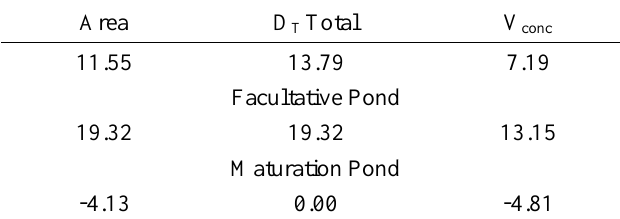
Percentage reduction in Area, D T , and V conc